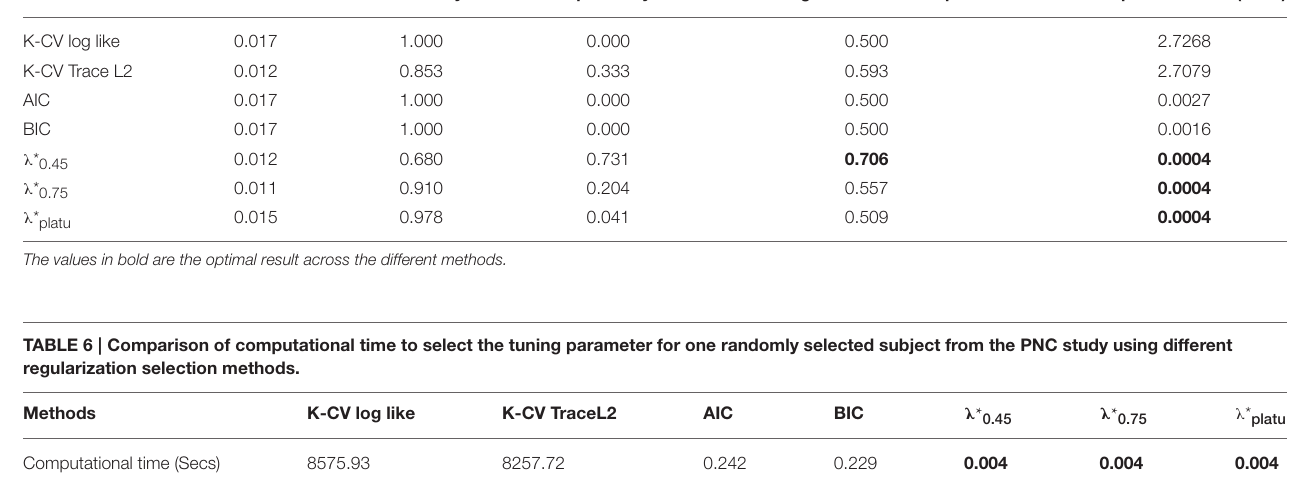
TABLE 5 | Averaged performance of regularization methods across various sparsity levels with the simulated data. Methods